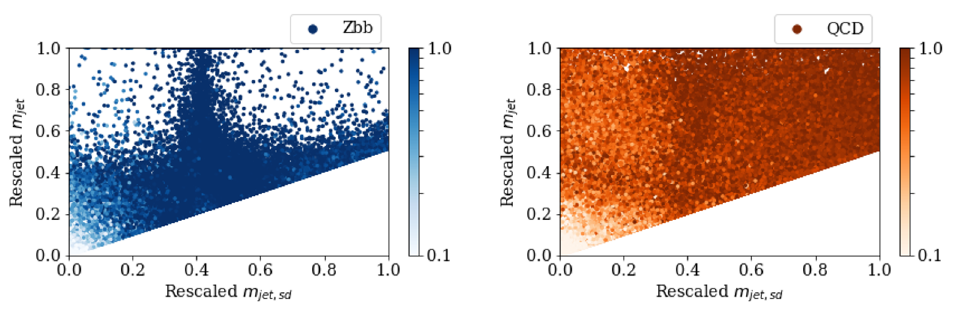
Figure 21. Averaged relevance score of 5 models for the particle list CNN for τ 1 . 0 the Zbb and QCD samples. The features to compare are selected from figure 24.